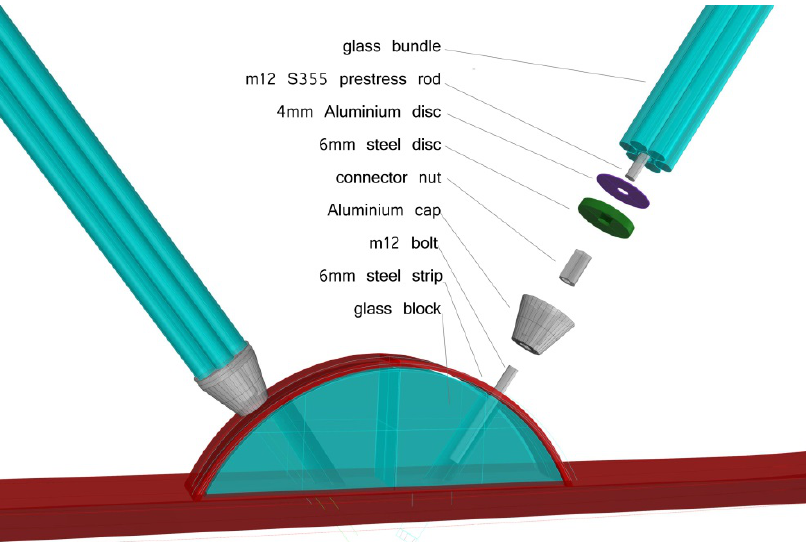
Fig. 17 Showing end solution for the glass